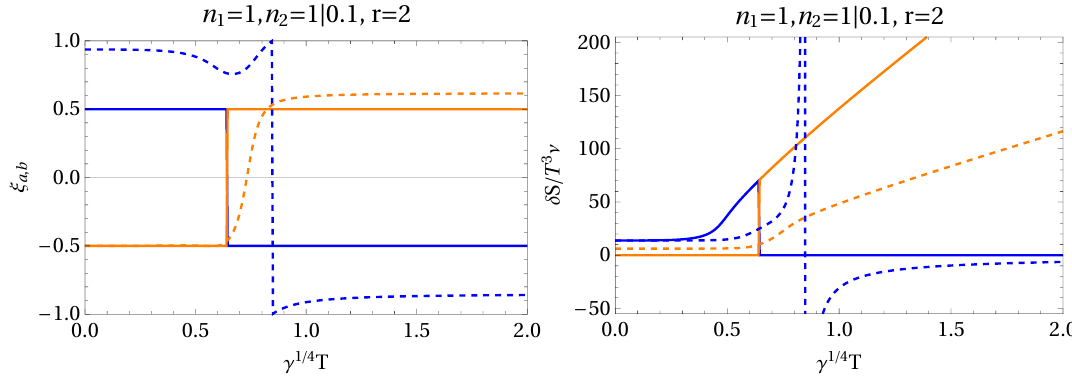
Figure 12 . Left panel: the relation between the velocity amplitudes (cid:23) and ~ (cid:23) of the sound eigen- modes displayed in (cid:12)gure 8 in the form (cid:24) (cid:17) 2 arctan(~ (cid:23)=(cid:23) ); right panel: the corresponding (cid:13)uc- (cid:25) tuation amplitude of the total entropy density, (cid:14) S (cid:17) (cid:14) S (cid:22) =0 , divided by (cid:23) T 3 . Mode a and b are given in blue and orange, respectively, with full and dashed lines representing n 1 = n 2 = 1 and n 1 = 1 ; n 2 = 1 = 10. The divergence of (cid:14) S = ( T 3 (cid:23) ) of mode a at one value of (cid:13) 1 = 4 T is due to a zero of (cid:23) (corresponding to j (cid:24) a j = 1); here a velocity (cid:12)eld is present only in subsystem